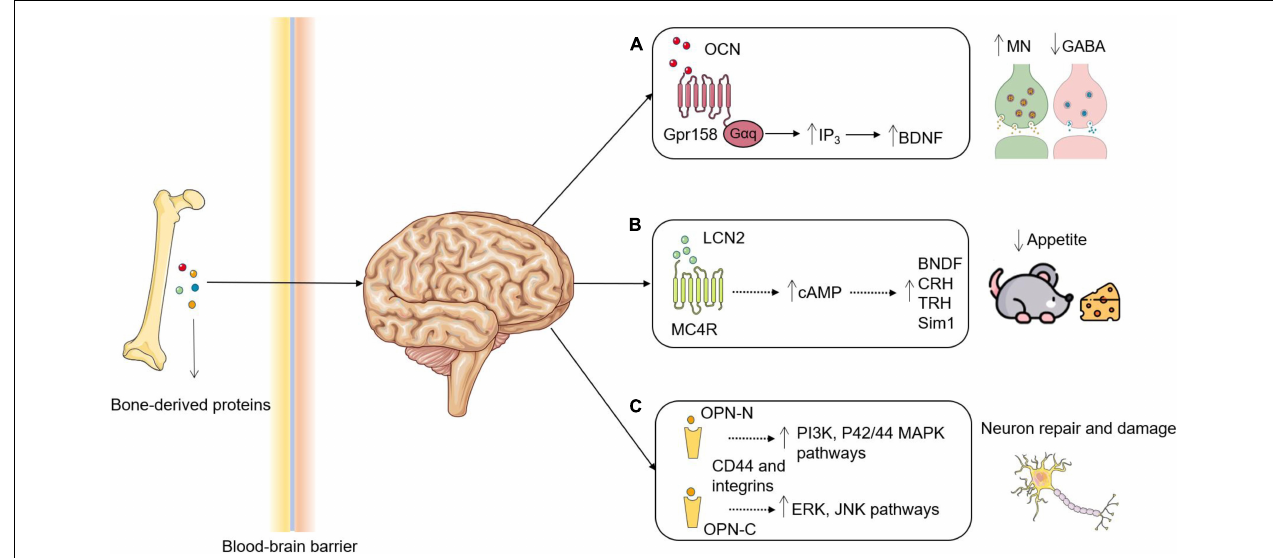
FIGURE 1 | Roles of bone-derived proteins in brain functions. (A) OCN is decarboxylated and secreted by osteoblasts and enters the circulation to act as an endocrine hormone. OCN transverses the BBB, where it binds to Gpr158 in the brain to increase the synthesis of BDNF through upregulating IP3 and eventually results in promoting MN synthesis and inhibiting GABA production. (B) LCN2 is secreted by osteoblasts and binds to MC4R in the hypothalamus after crossing the BBB. Activation of MC4R by LCN2 induces cAMP and promotes the synthesis of BDNF, CRH, TRH and Sim1 to suppress appetite. (C) The proteases cleavage may generate two OPN fragments: OPN-N and OPN-C. OPN-N binds with integrins to activate PI3K and P42/44 MAPK pathways leading to a protective role, whereas OPN-C binds with CD44 to activate ERK and JNK pathways leading to a detrimental role. OCN, Osteocalcin; BBB, blood-brain barrier; Gpr158, G protein-coupled receptor 158; BDNF, brain-derived neurotrophic factor; IP3, inositol triphosphate; MN, monoamine neurotransmitters; G α q, guanine nucleotide-binding protein α -q; LCN2, lipocalin-2; MC4R, melanocortin 4 receptor; cAMP, cyclic adenosine monophosphate; CRH, corticotropin releasing hormone; TRH, thyrotropin-releasing hormone; Sim1, single-minded homolog 1; OPN, osteopontin. OPN-N/C, N/C-terminal fragment of OPN. Figures were produced using Servier Medical Art, modified.